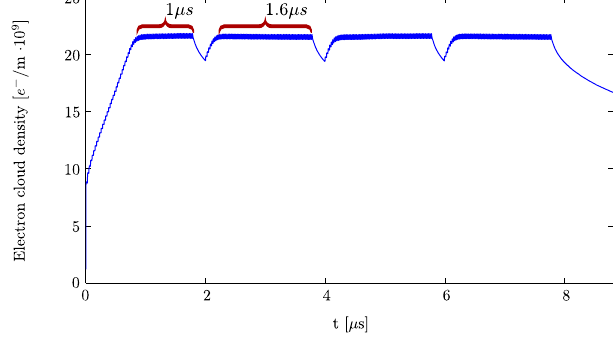
FIG. 12. Electron cloud simulation results (MBB-type SPS vacuum chamber) for the nominal LHC 25 ns beam (courtesy G. Rumolo).